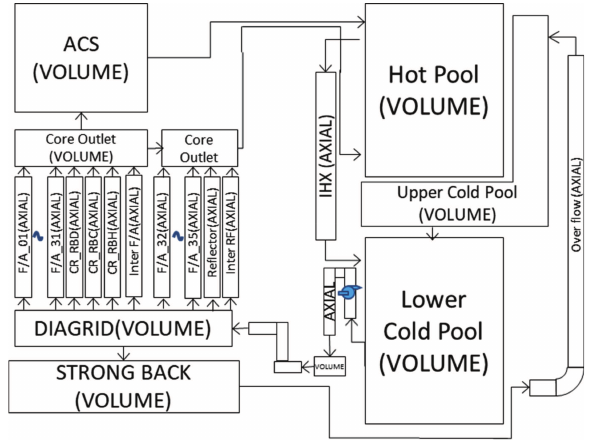
Fig. 2. CATHARE analysis model.